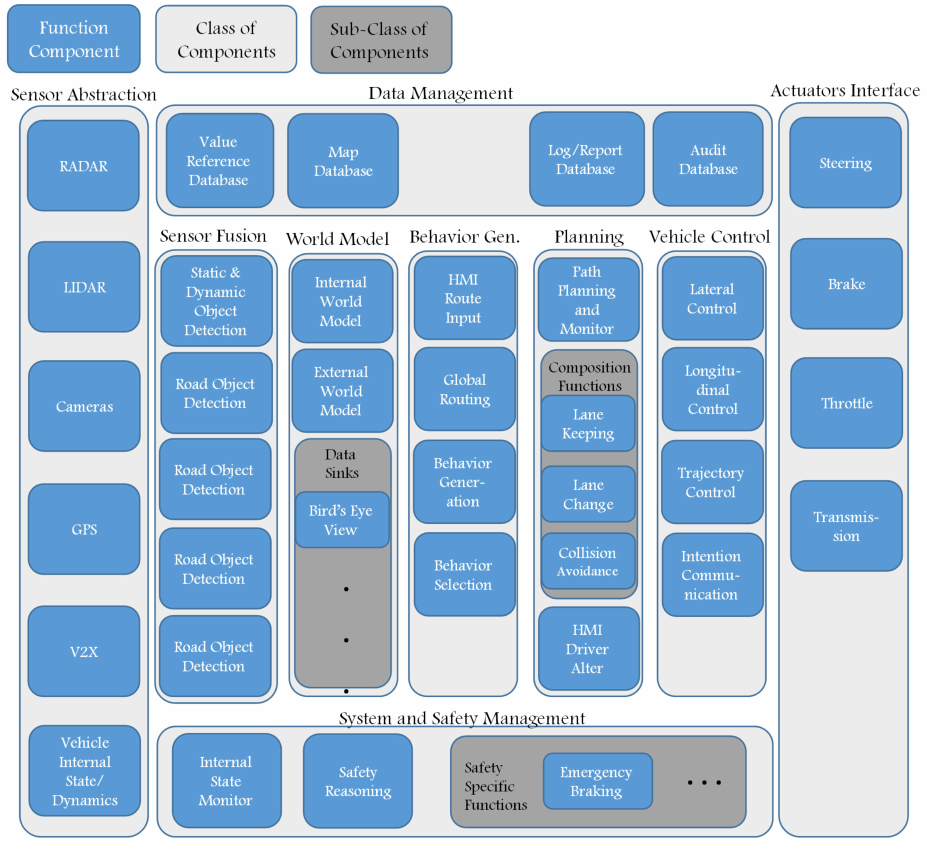
Figure 3. Components for autonomous vehicle